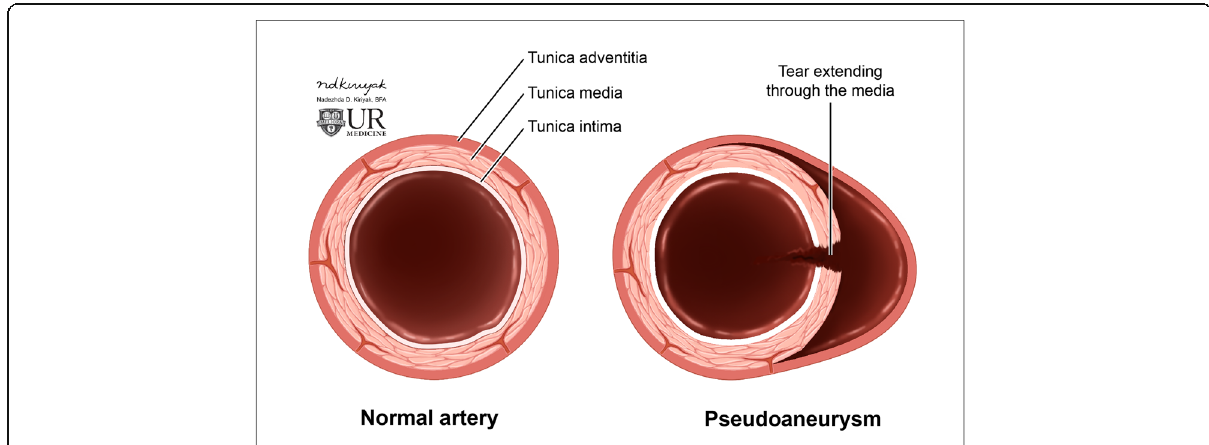
Fig. 13 Arterial pseudoaneurysm. Illustration of the normal layers of an arterial vessel (left). Pseudoaneurysm occurs when a tear through the tunica intima and media layers results in blood only contained by the adventitial layer